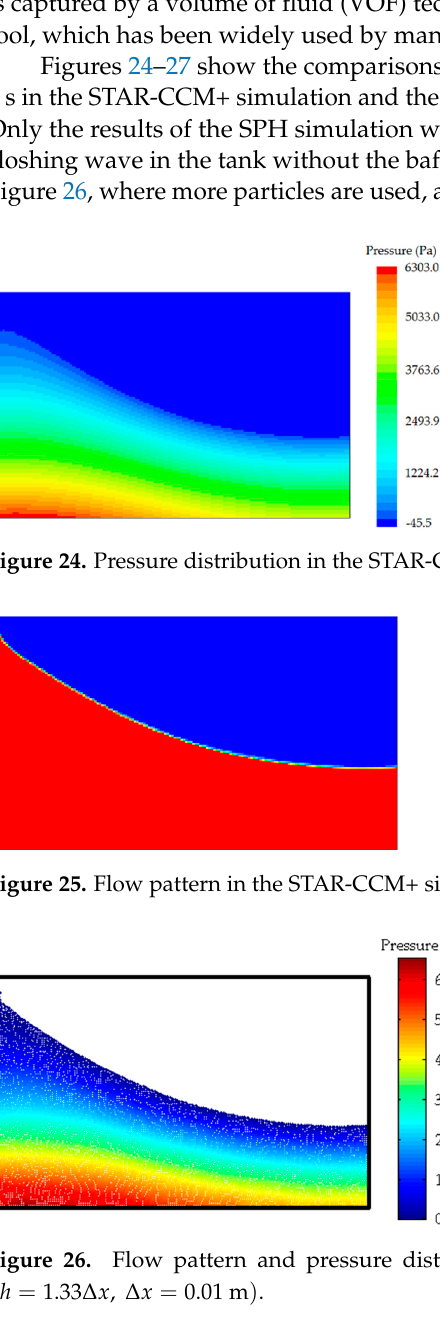
Figure 27. Flow pattern and pressure distribution in the SPH simulation without the baffle (